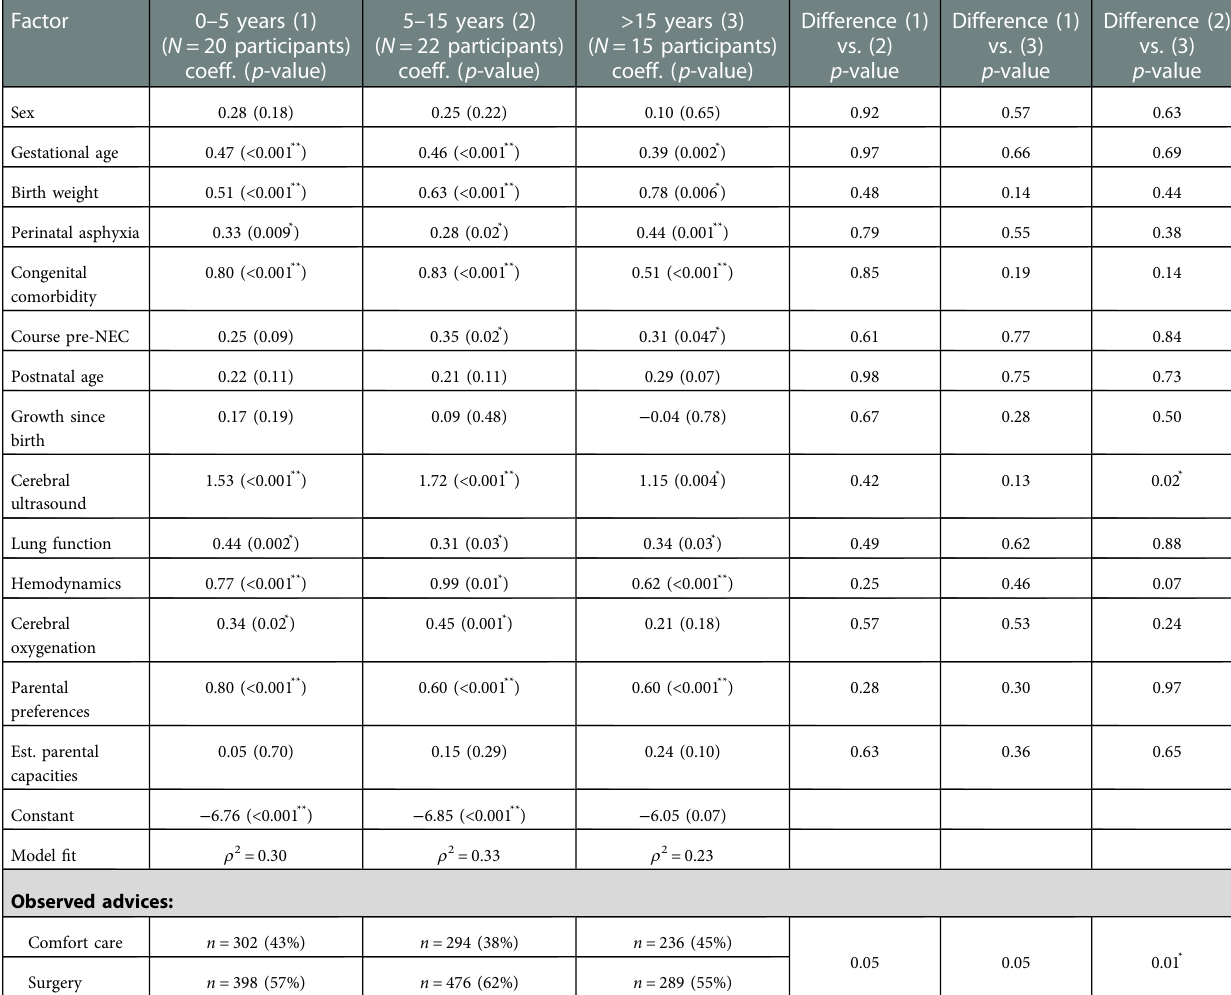
TABLE 4 Estimated linear weight of the work experience subgroup analysis, divided in three groups: 0 – 5 years (group 1), 5 – 15 years (group 2) and >15 years (group 3) of working experience as a neonatologist or pediatric surgeon.